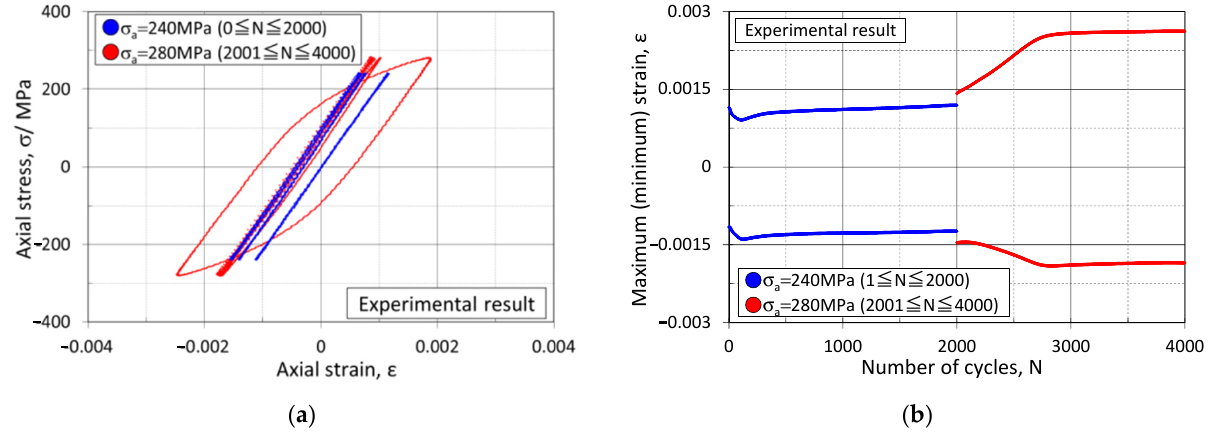
Figure 6. ( a ) Experimental stress and strain curves under two-step amplitude loading test; ( b ) experimental relationships between ε max- ε min and the number of cycles under two-step amplitude loading test.